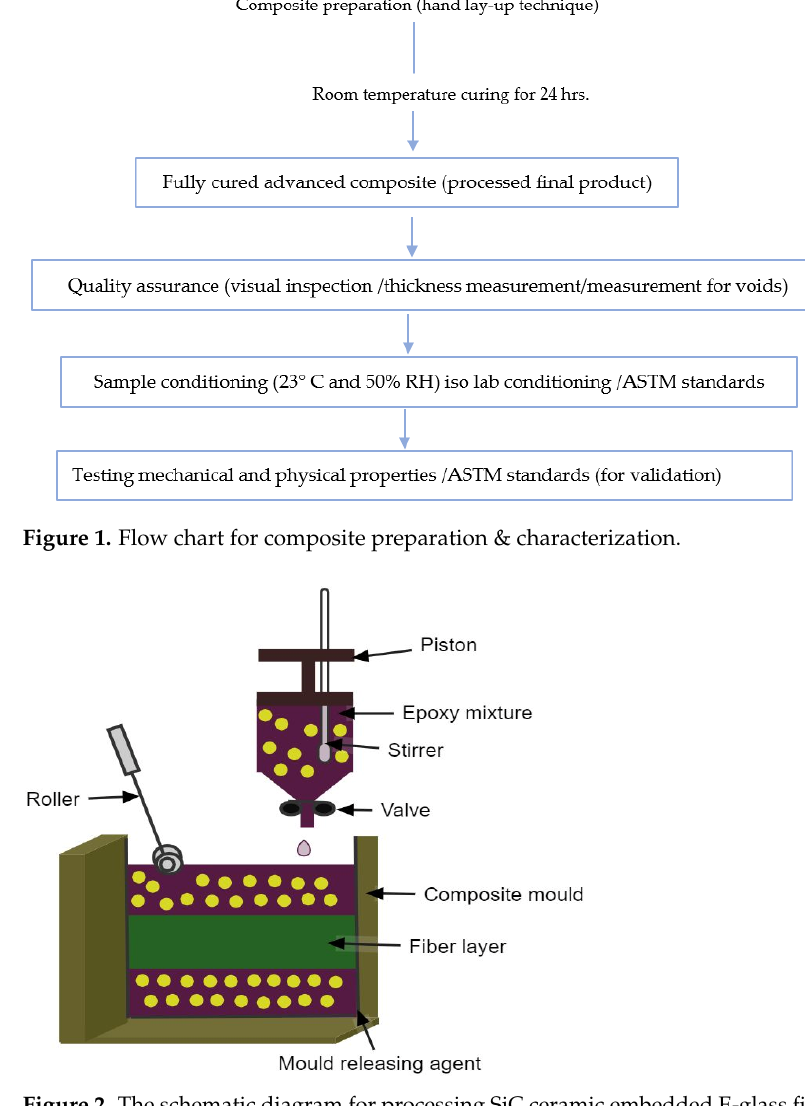
Figure 2. The schematic diagram for processing SiC ceramic embedded E-glass fiber reinforced epoxy matrix composites using hand layup technique.